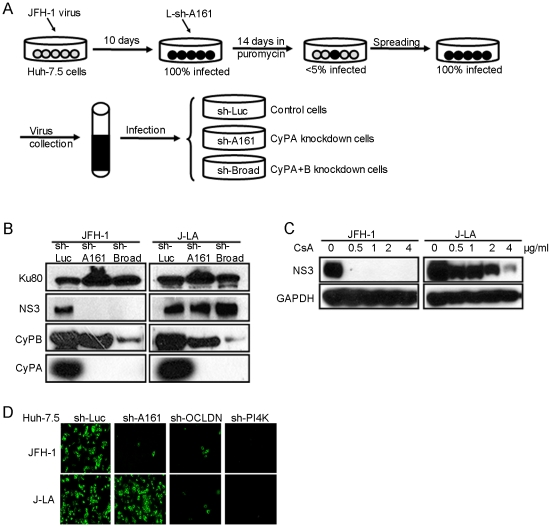
CoFIM selection of a full-length HCV that is less dependent on CyPA.(A) A diagram of CoFIM selection #1. Sh-A161 was introduced into infected cells and selected with puromycin. Stable cells were then passaged until all cells became infected. (B) The selected mutant virus (J-LA) efficiently infects CyPA and CyPB knockdown cells. Supernatant collected from (A) was used to infect cells harboring indicated shRNAs; infected cell lysates were collected 4 days after infection and analyzed by SDS-PAGE and western blotting. A cellular protein, Ku80, was detected as a loading control. (C) J-LA is more resistant to CsA treatment than WT JFH-1. Huh-7.5 sh-Luc cells were infected with JFH-1 or J-LA for 24 h before CsA was added to the culture medium. The cells were incubated for 4 more days before being lysed and analyzed for NS3 expression. (D) J-LA virus efficiently infects CyPA knockdown cells but not PI4K or Occludin knockdown cells. Equal numbers of Huh-7.5 cells harboring either control or the indicated shRNAs were seeded and infected with either JFH-1 or J-LA virus. Five days after infection, cells were fixed and subjected to anti-NS3 antibody staining. Data shown in (B), (C), and (D) represent two independent experiments.